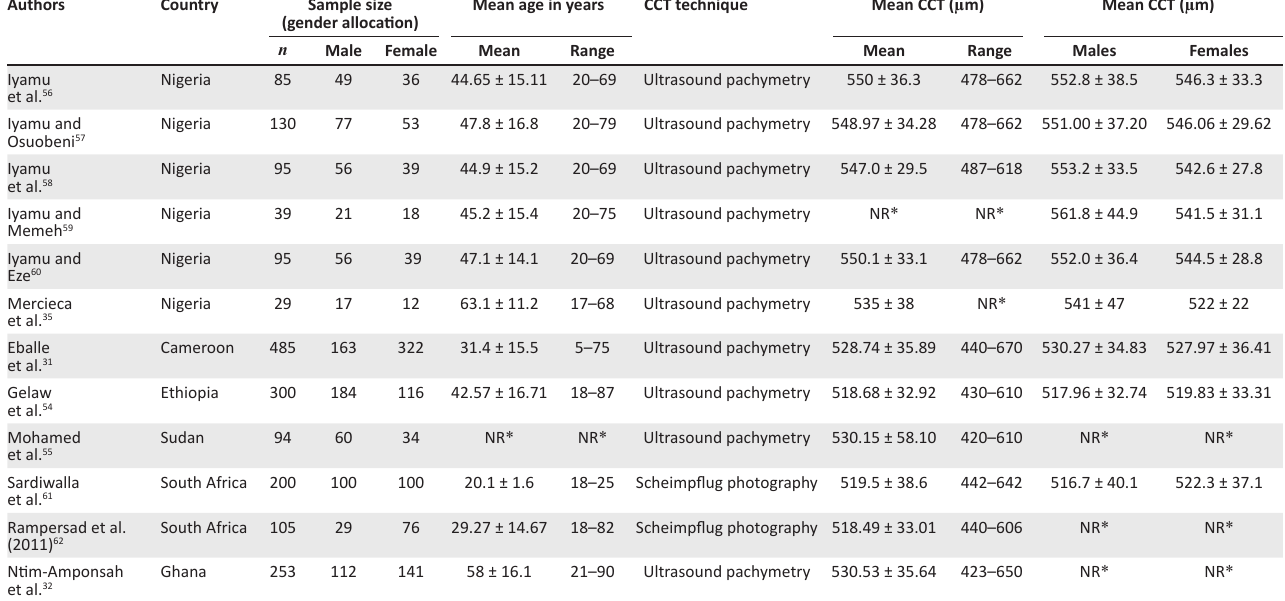
TABLE 1: Summary of studies of central corneal thickness in African